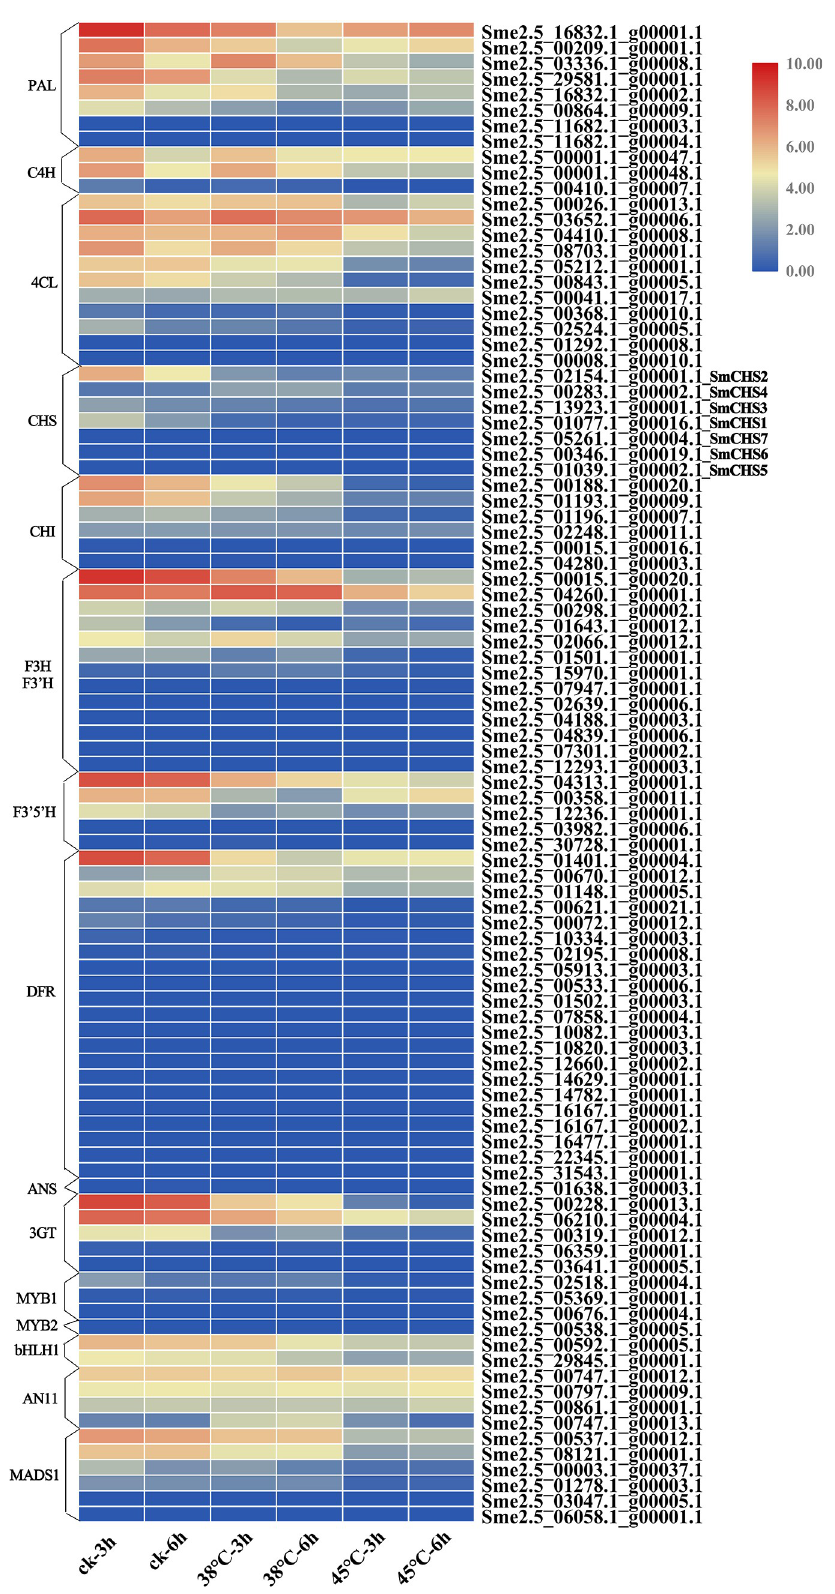
Fig 5. Heatmap of 96 key anthocyanin biosynthesis genes expression level in eggplants peel under heat stress. The color box from blue to red indicate an increased expression level. https://doi.org/10.1371/journal.pone.0226537.g005 PLOS ONE | https://doi.org/10.1371/journal.pone.0226537 April 17,